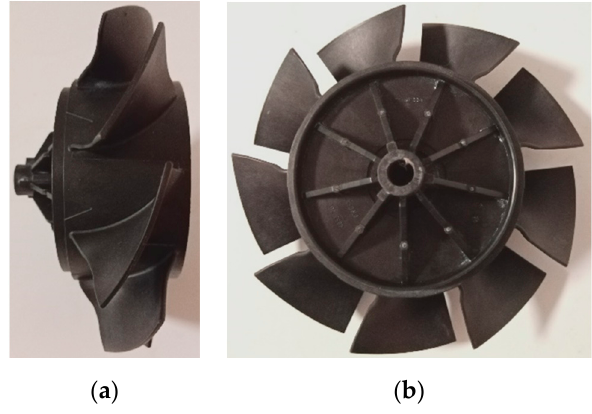
Figure 5. Physical model of rotor: ( a ) left view, ( b ) front view.